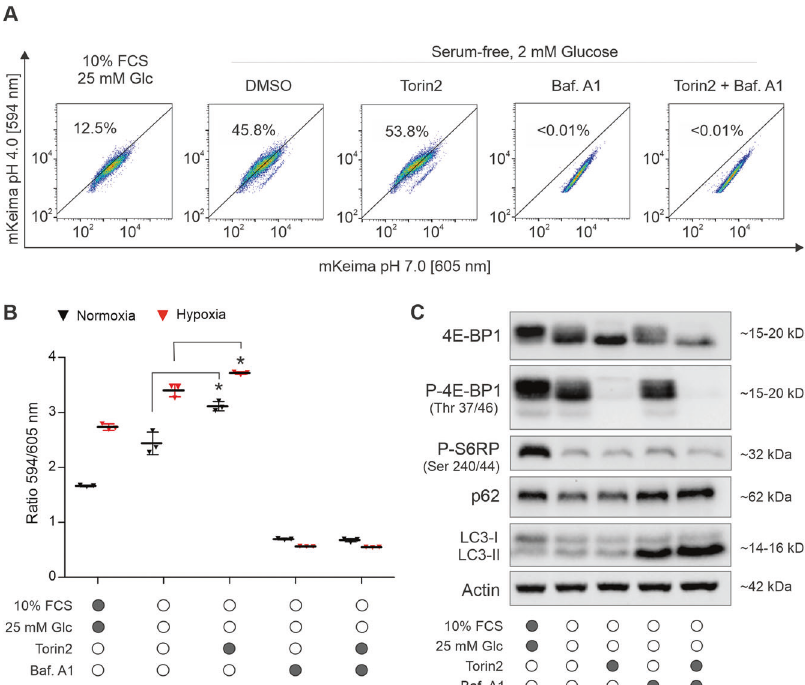
Fig. 1 Regulation of autophagy in response to starvation, hypoxia and mTOR inhibition. A Autophagic activity was analyzed by fl ow cytometry in LN-229 cells stably expressing mKeima-LC3. Cells were cultured in hypoxia in either control or starvation medium for 24 h and were treated with torin2 (100 nM) or ba fi lomycin A1 (100 nM). Numbers indicate the percentage of autophagy-positive cells. B Quanti fi cation of fl ow cytometry as mean ± SD ( n = 3, ** p < 0.01, Student ’ s t -test). C Activation of autophagy in LN-229 cells cultured under